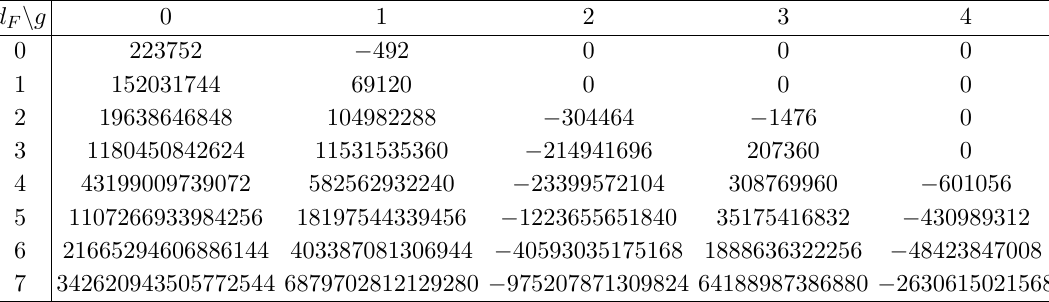
at base degree 2